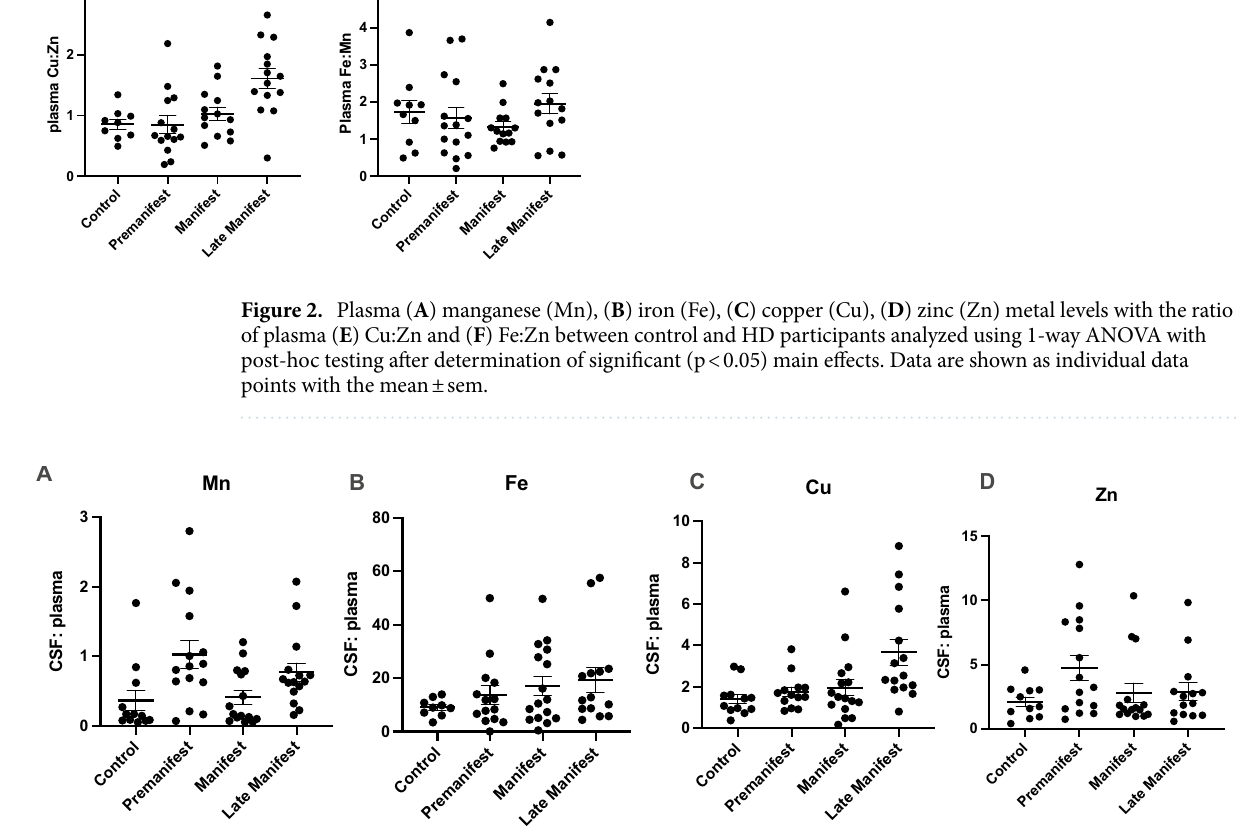
Figure 3. The ratio of cerebrospinal fluid (CSF) and plasma ( A ) manganese (Mn), ( B ) Iron (Fe), ( C ) Copper (Cu), and ( D ) Zinc (Zn) in control and HD participants. Differences in CSF: plasma metal ratio were analyzed using a 1-way ANOVA with post-hoc testing after determination of significant (p < 0.05) main effects. Data are shown as individual data points with the mean ±